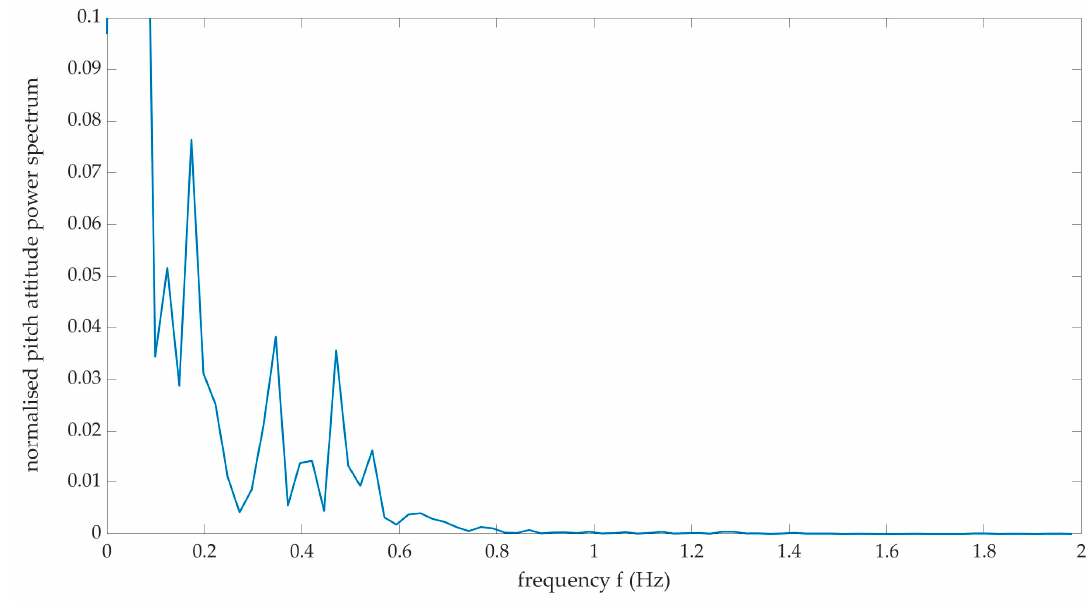
Figure 8. Pitch attitude spectra taken from time series pitch attitude data.